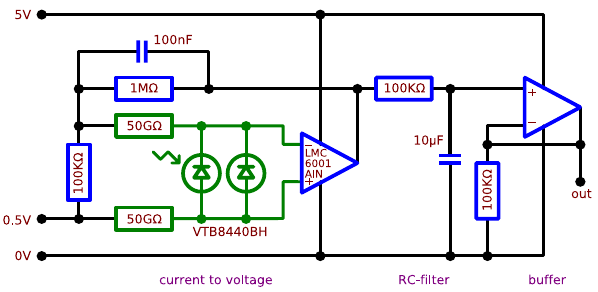
Fig. 3. The electronic circuit used in the detector. Note that only 2 of the 8 photodiodes are shown. The parts drawn in green are not mounted on the circuit board in order to minimize the effect of sur- face leakage